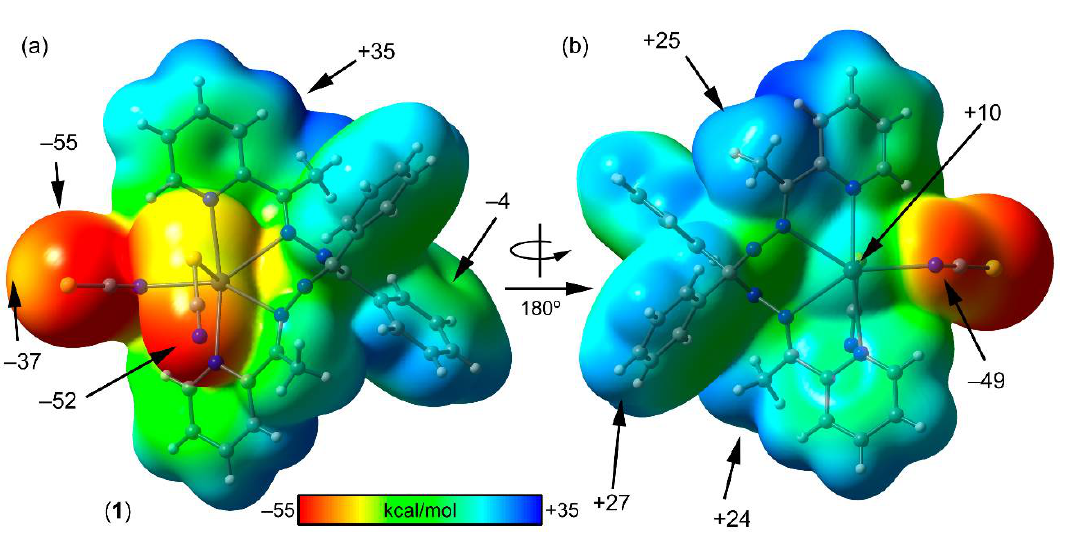
Figure 11. Molecular electrostatic potential (MEP) surface (isosurface 0.001 a.u.) of the two sides ( a ) and ( b ) of compound ( 1 ) at the PBE1PBE-D3/def2-TZVP. The MEP values at selected points of the surface are given in kcal/mol.